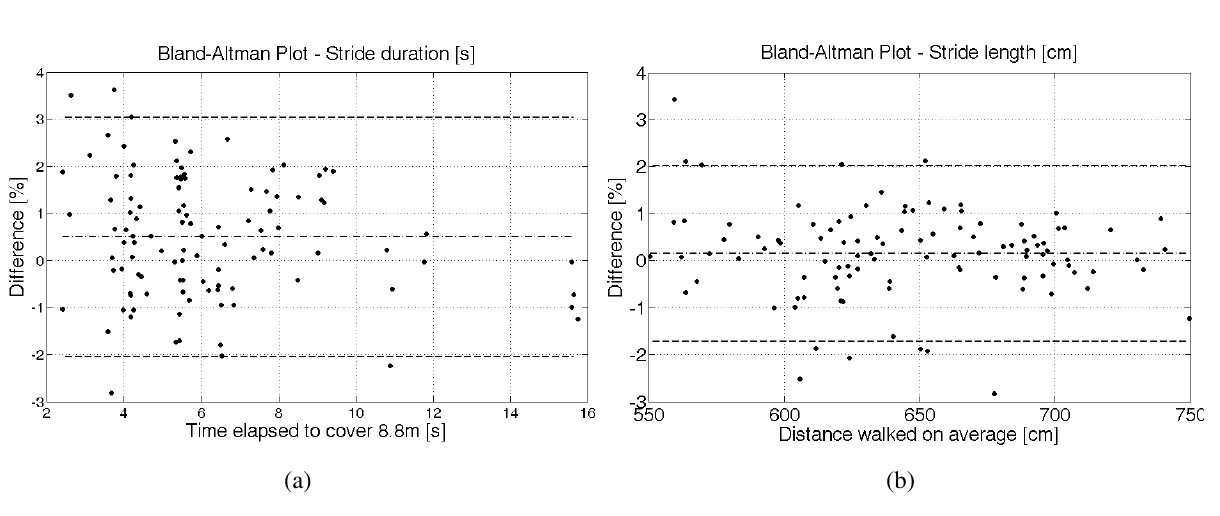
Figure 6. Bland–Altman plots for percentage differences for ( a ) the step duration and ( b ) the step length estimated with inertial measurement units (IMUs) and GAITRite